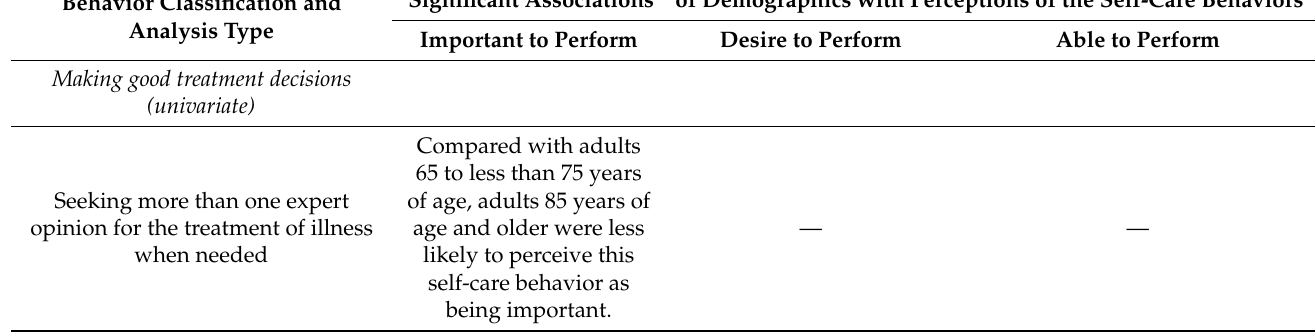
Table 5. Summary of perceived importance, desirability, and ability to perform 11 patient engagement self-care behaviors for making good treatment decisions and participating in